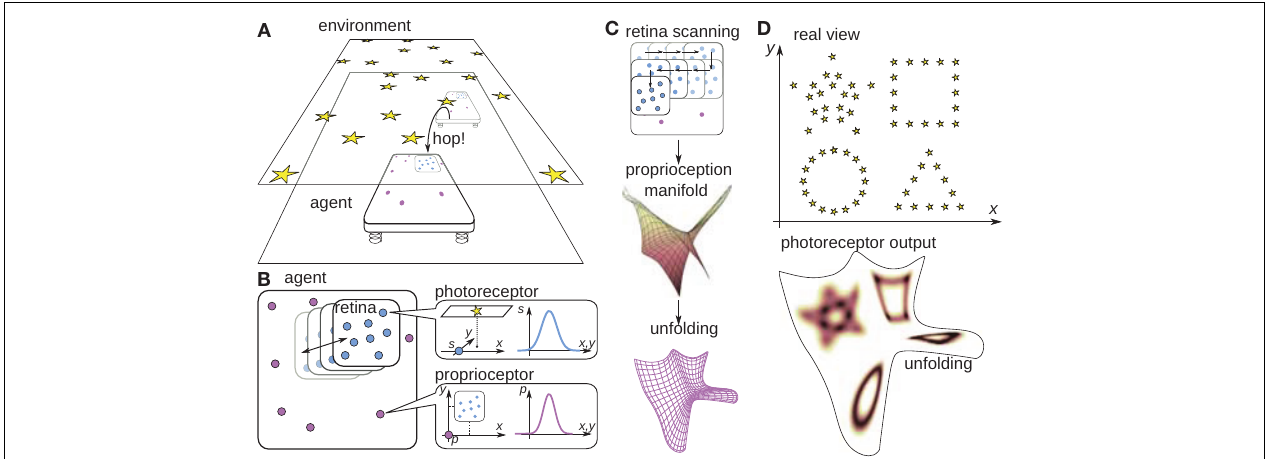
FIGURE 2 | The tray-like two-dimensional agent . (A) The agent inhabits a plane where it can perform uncontrolled hops (or equivalently, the environment can shift through unknown distances), resulting in the translation of the agent’s body in an unknown direction through an unknown distance. Outside of the agent’s plane there is an environment made of light sources. The agent can sense the light sources with nine photoreceptors placed on its mobile retina (B) , which can translate with the help of muscles, and whose position is sensed by eight pressure-sensitive proprioceptive cells scattered over the agent’s body. As the retina performs the scanning motion (C) , the proprioceptors take values lying in a two-dimensional proprioceptive manifold inside the eight-dimensional space of the possible proprioceptive outputs. This manifold can be unfolded into a plane. (D) An example environment and the output of one photoreceptor over this unfolding as the agent performs scanning movements of the retina. This unfolding will be used hereafter in order to illustrate the outputs of the photoreceptors as the agent performs scanning movements of the retina.